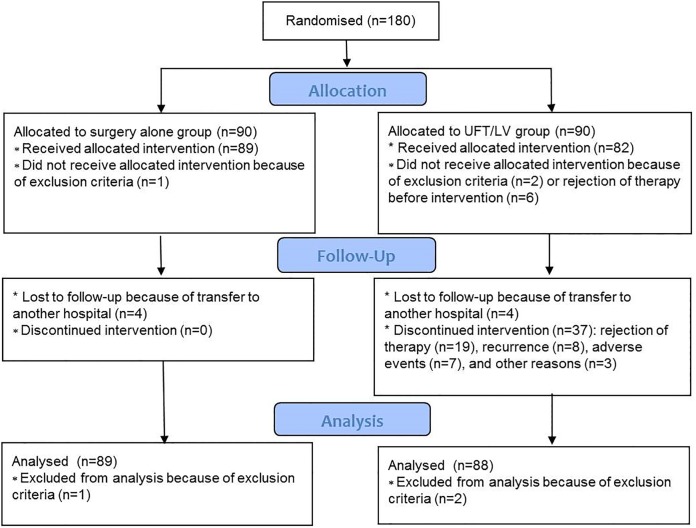
The trial profile.The Participant flow is shown.